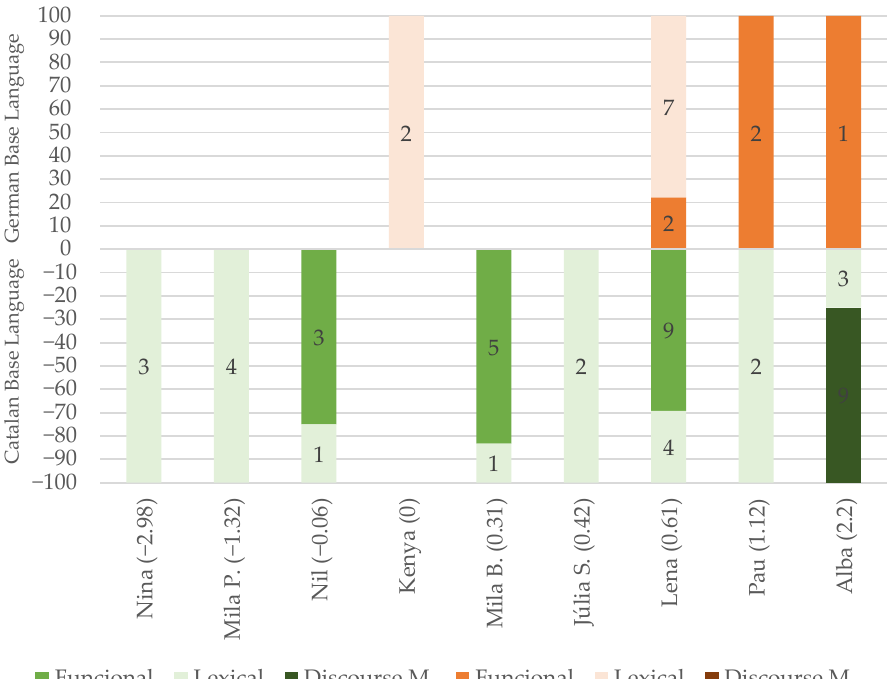
Figure 19. Functional and lexical intrasentential CS, discourse markers according to the base language and child’s language dominance (child (MLUD)).